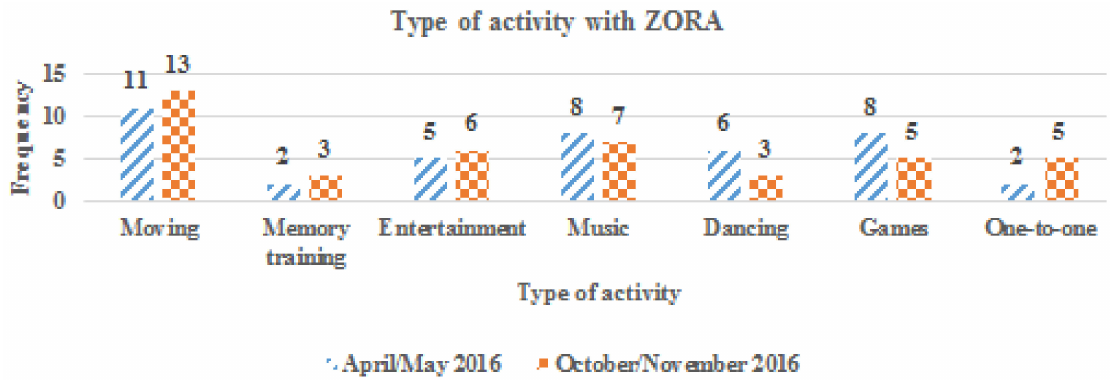
Figure 9. The number of locations where the different types of activities with Zora were given